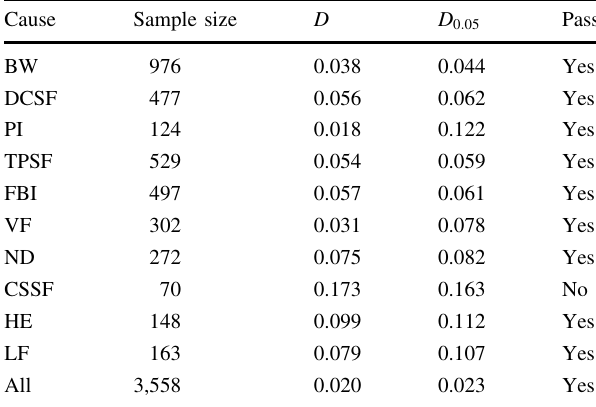
Table 7 Results of the K–S test for testing